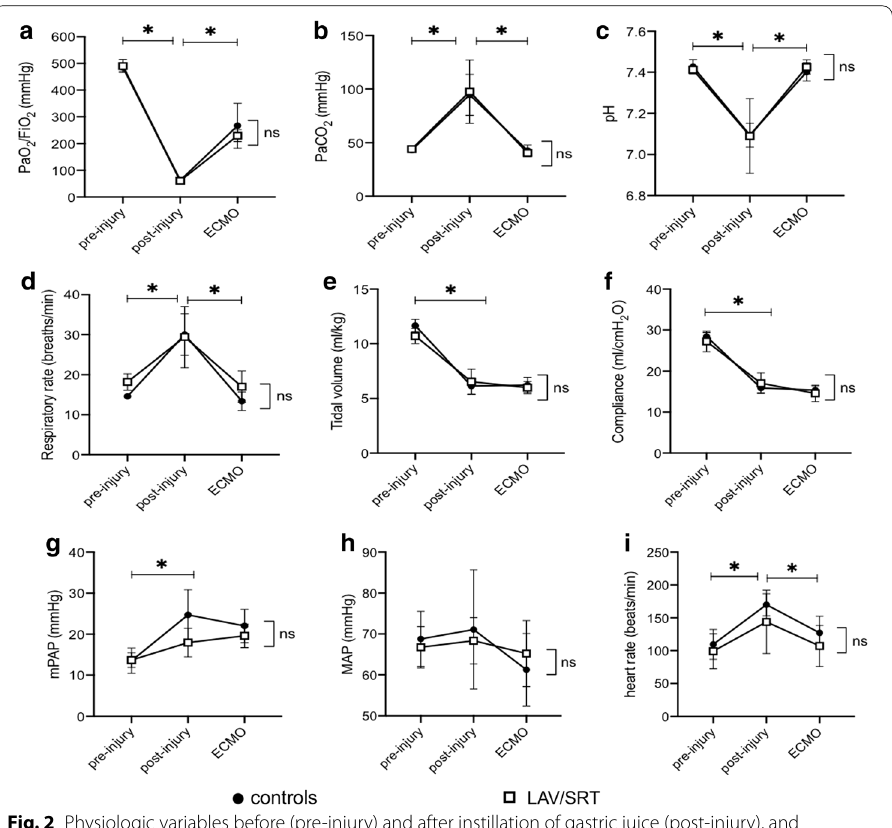
Fig. 2 Physiologic variables before (pre-injury) and after instillation of gastric juice (post-injury), and following ECMO initiation. Data are presented as mean SD. a PaO 2 /FiO 2 ; b PaCO 2 ; c pH; d respiratory ± rate; e expired tidal volume in ml/kg; (F) compliance; g mean pulmonary artery pressure (mPAP); h mean arterial systemic pressure (MAP); i heart rate. Two-way ANOVA for repeated measures: * p < 0.05 pre-injury vs post-injury and post-injury vs